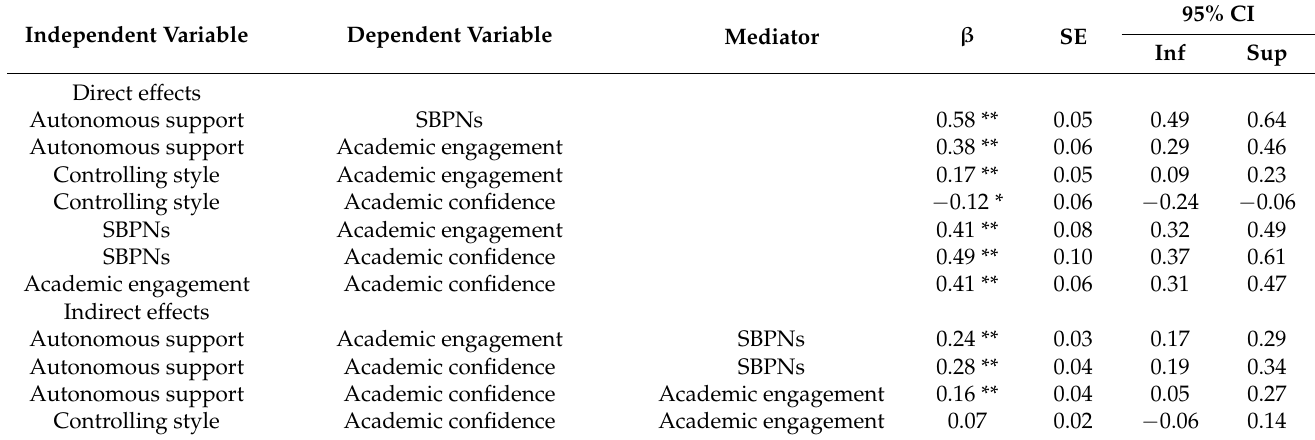
Table 2. Estimation of significant standardized parameters and statistics of the mediation